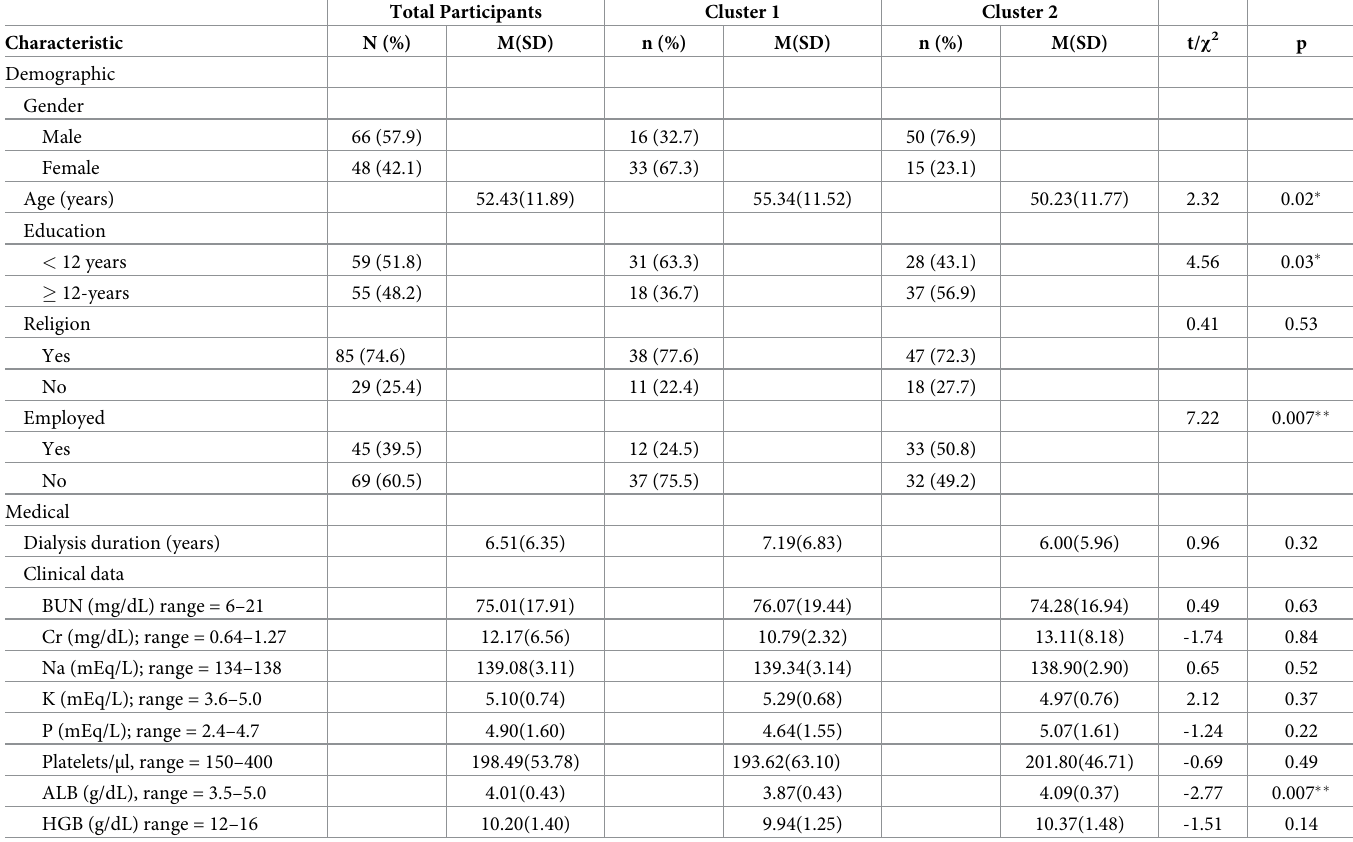
Table 1. Demographic and medical characteristics of total participants (N = 114), Cluster 1 (n = 49), Cluster 2 (n = 65) and differences between the two clusters.